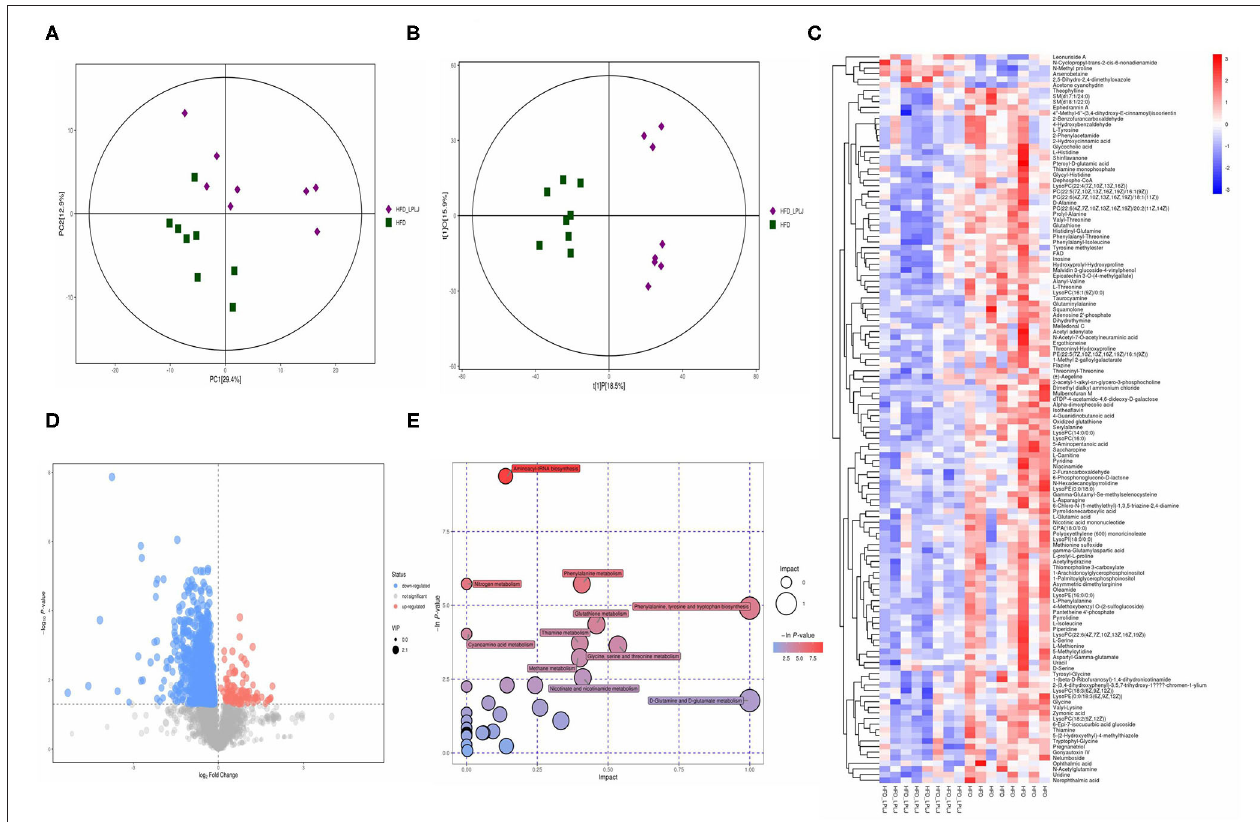
FIGURE 8 | Liver metabolomic profiling by UPLC-QTOF/MS in positive model (ESI + ) ( n = 8 for each group). (A) PCA score plot for the HFD and LPLJ groups; (B) OPLS-DA score plot for the HFD and LPLJ groups; (C) Heatmap of relative abundance of significantly different metabolites (VIP > 1.0, and p < 0.05) between the HFD and LPLJ groups; (D) Permutation test from PLS-DA models, (E) The metabolic pathway impact prediction between the HFD and LPLJ groups in liver based on KEGG online database. The -ln( p ) values from the pathway enrichment analysis are indicated on the horizontal axis, and the impact values are indicated on the vertical